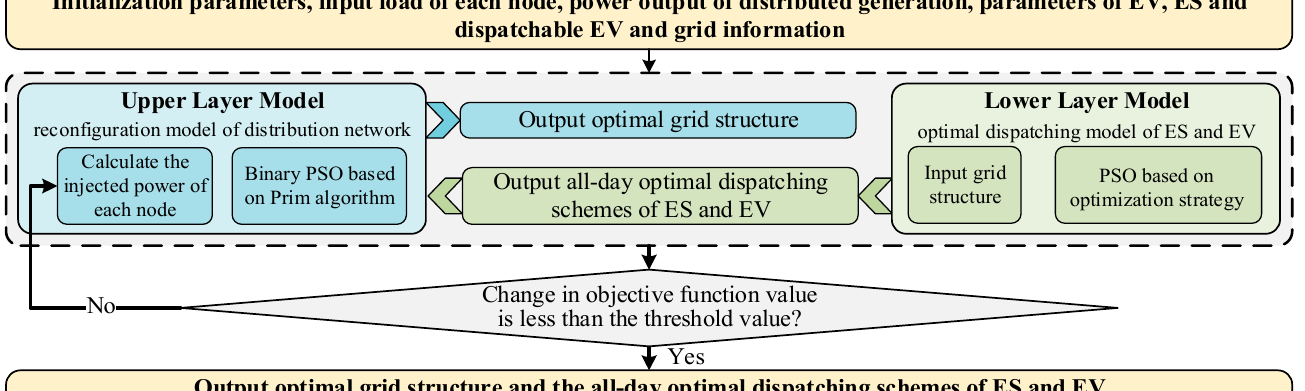
Figure 3. Solving process of collaborative optimized operation model of multi-character distribution network.